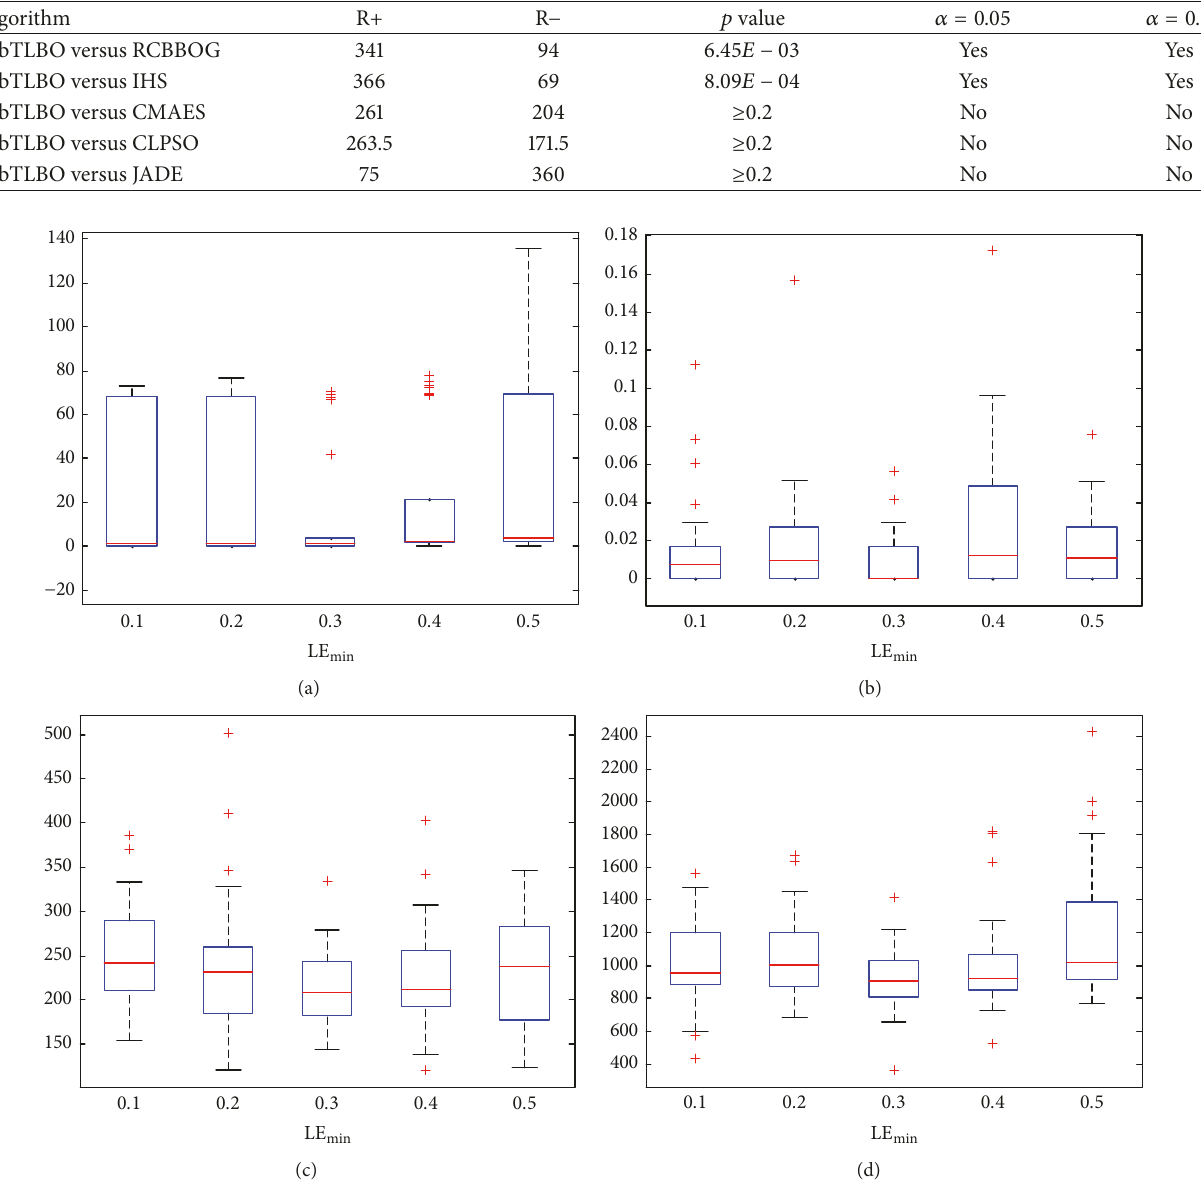
Figure 5: Box plots of LebTLBO’s results with different LE min : (a) F4, (b) F7, (c) F20, and (d)